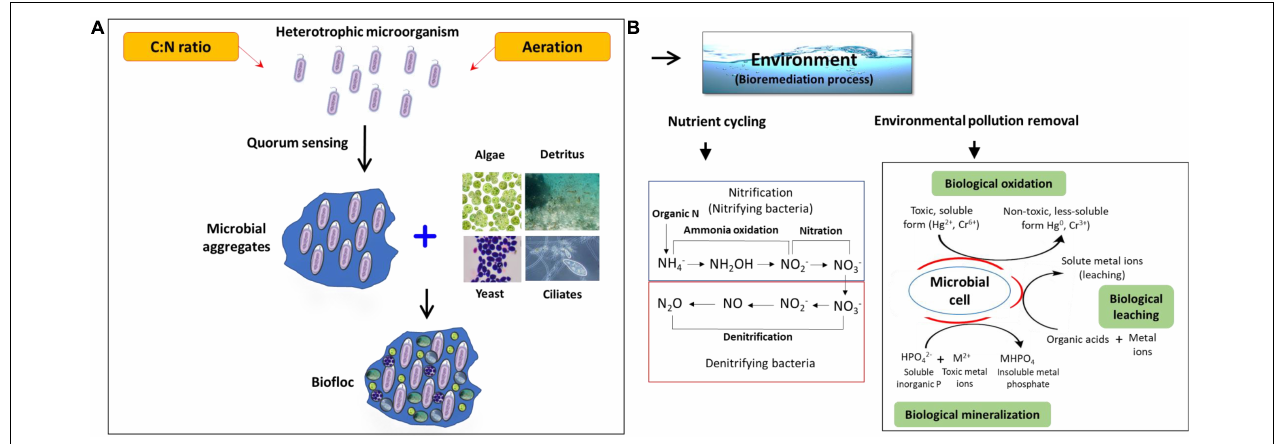
FIGURE 2 | Schematic overview on the possible role of the biofloc microbiome. (A) Development of a biofloc system; (B) potential role of the biofloc system in the bioremediation